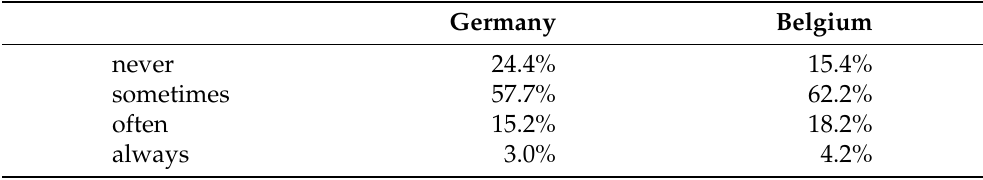
Table 4. Buying frequency of organic/free-range